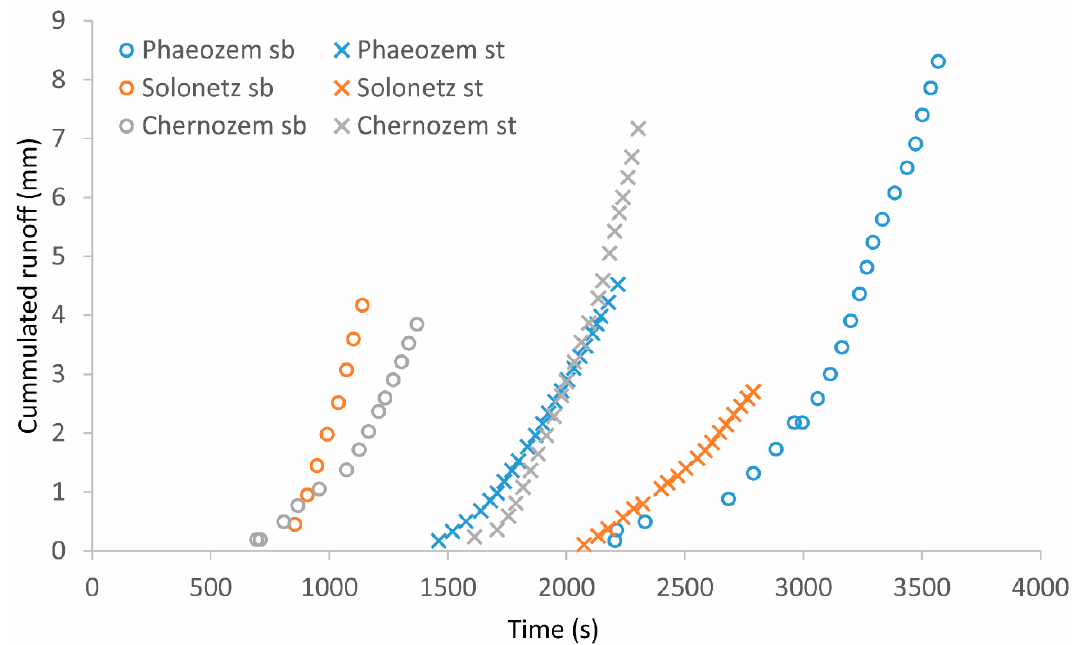
Figure 3. Temporal changes in runoff intensity. Circles indicate seedbed condition; crosses indicate stubble condition. The steepness of linear functions fitted to the last 6–10 data points of each measurement provides final runoff intensity.